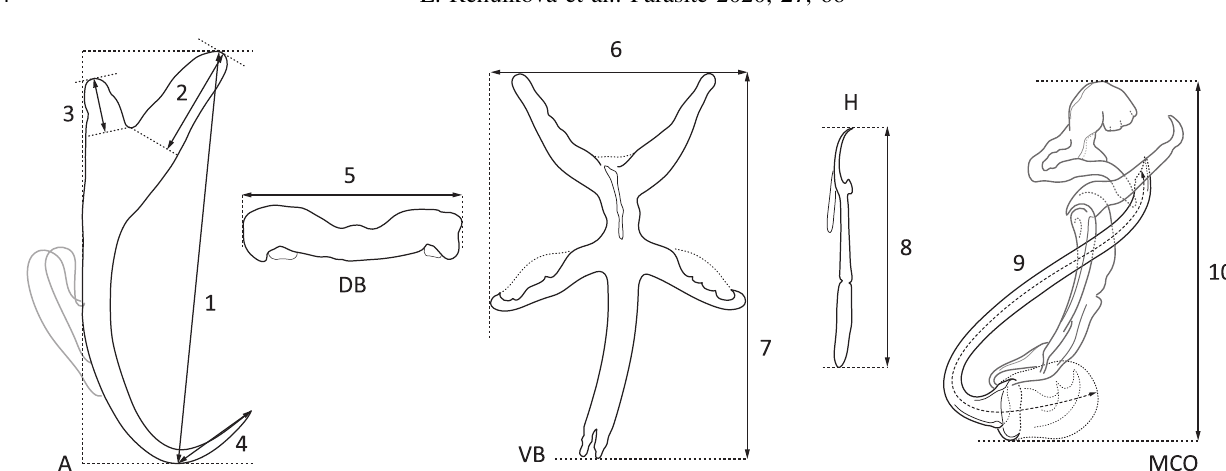
Figure 2. Scheme of measurements for sclerotized structures of Dactylogyrus spp. A, anchor (1 – total length, 2 – inner root length, 3 – outer root length, 4 – point length); DB, dorsal bar (5 – width); VB, ventral bar (6 – width, 7 – length); H, hook (8 – length); MCO, male copulatory organ (9 – tube curved length; 10 – total straight